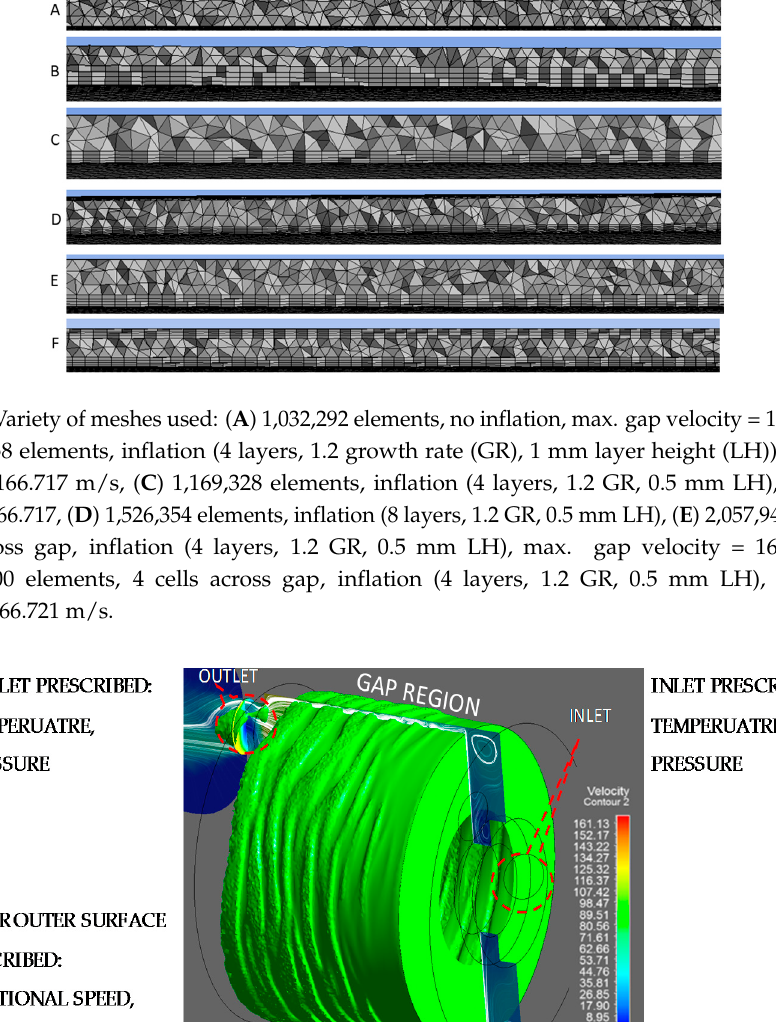
Figure 15. CFD numerical simulation boundary condition prescription.